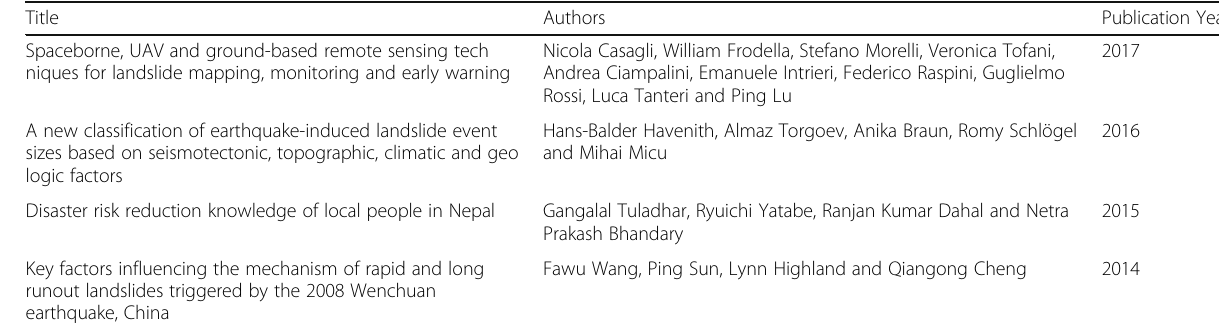
Table 1 Best Papers of the Geoenvironmental Disasters in the first 4 years